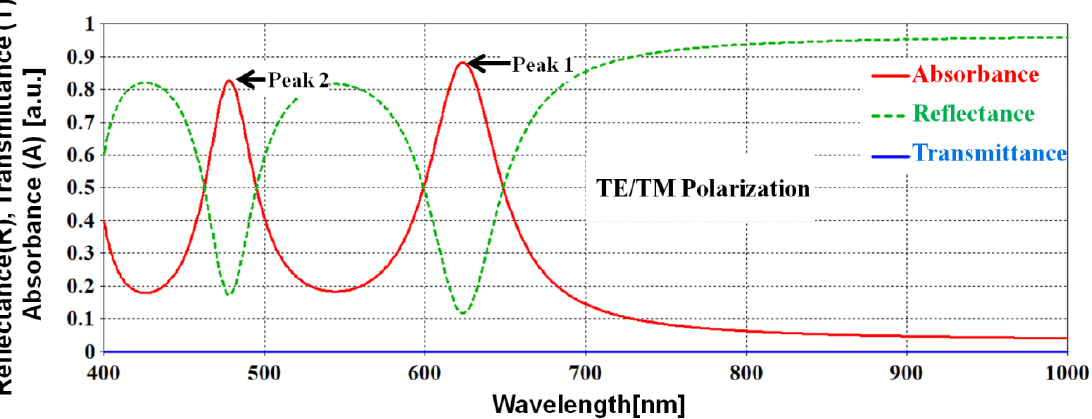
Figure 2. Reflectance (dashed-green), transmittance (blue), and absorbance (red) spectra with TE/TM polarizations for the proposed structure.